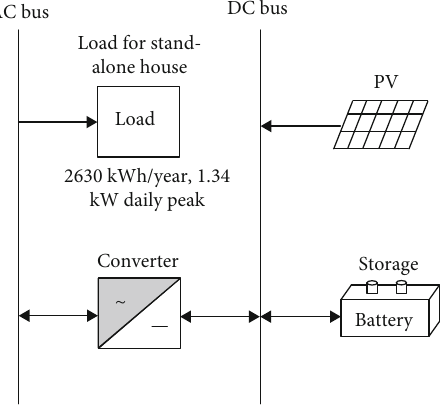
Figure 7: Schematic connection diagram of the stand-alone PV